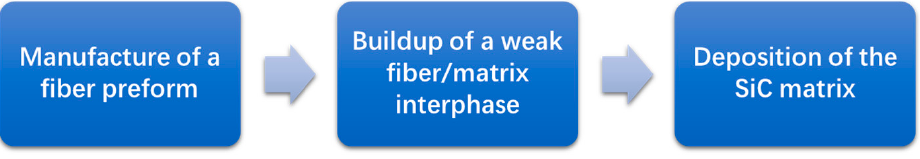
Figure 2. Manufacturing progress of CMC.